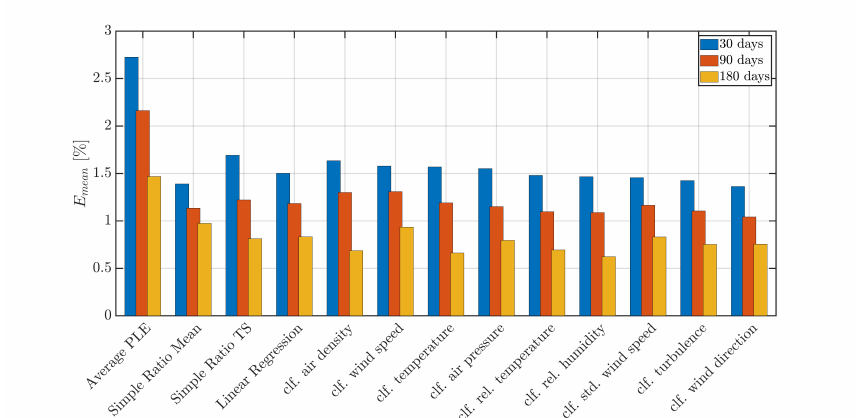
Figure 6. Extrapolation errors E mean for z 2 = 80 m , z t = 140 m and varying durations of the lidar measurement; for extrapolation without short-term lidar data, E mean =